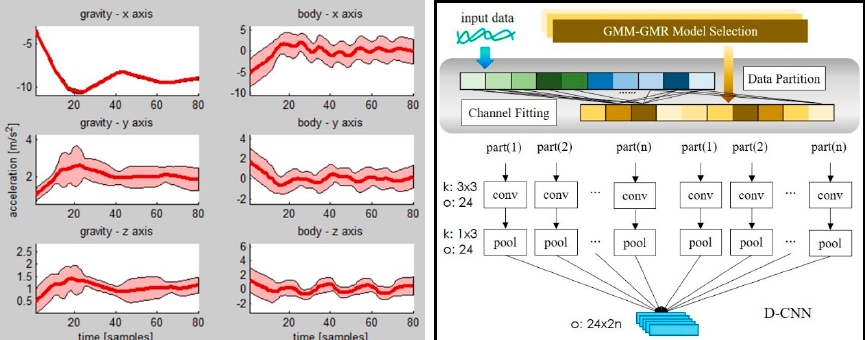
Figure 2. Left: Gaussian mixture model–Gaussian mixture regression (GMM-GMR) model of the “climb stairs” activity in the wearable human activity recognition folder (WHARF) dataset. Red line is acceleration value of every time point. Pink area is standard deviation of every time point. Right: Dynamic convolutional neural network (CNN) model. k is kernel size. o is the number of the output feature